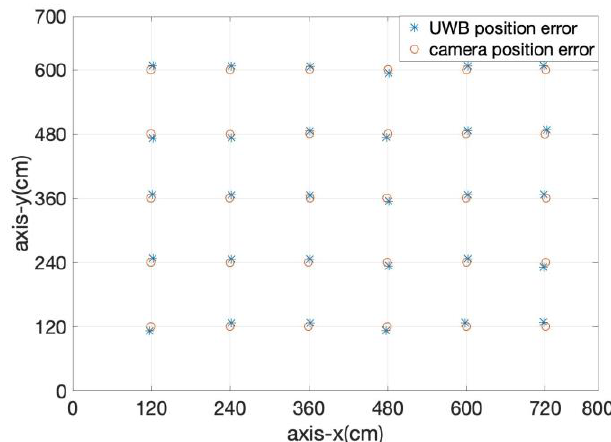
Figure 9. Localization results and setting values obtained by two localization methods.